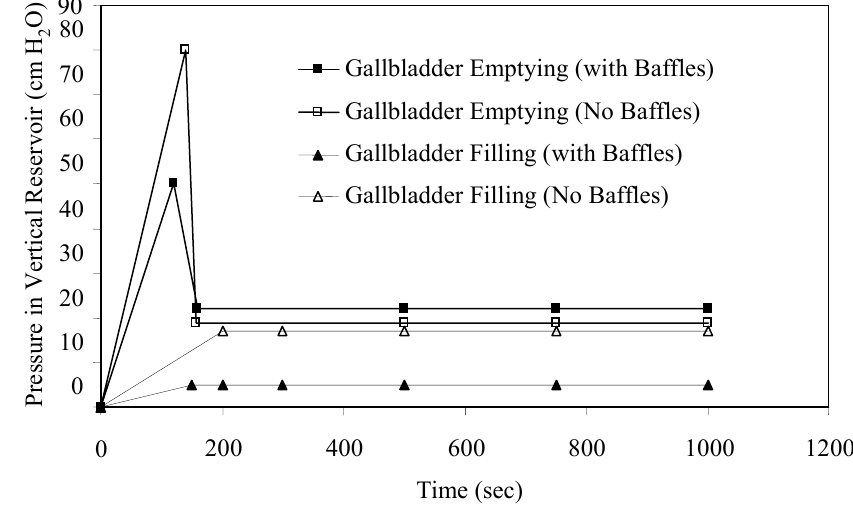
Fig. 5 Vertical reservoir pressure as a function of